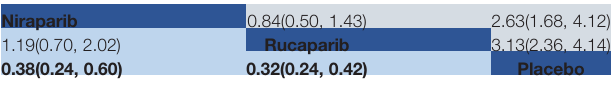
Placebo The data in bold are statistically signi fi